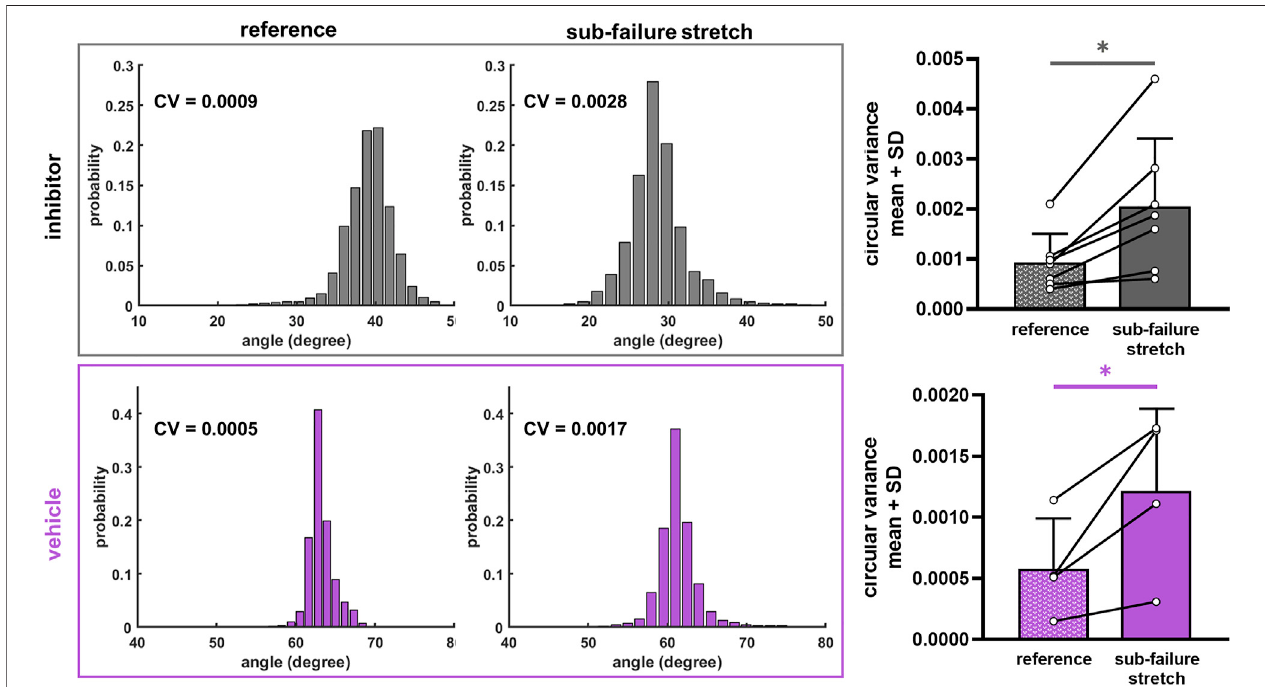
FIGURE 5 | Sub-failure stretch-induced collagen reorganization is similar in gels receiving vehicle and inhibitor treatment. Histograms show the probability that collagenwillorientatagivenangleforthereferencecondition andat thepeak force ofthesub-failurestretch foragel receivinginhibitor (S49)and vehicle (S46).Matched paired t-testsrevealthatstretchincreasesthecircularvarianceforallgelsinbothgroups(inhibitor: p =0.006, n =7;vehicle: p =0.028, n =4).Superimposeddatapoints represent quanti fi cation per gel. CV = circular variance.